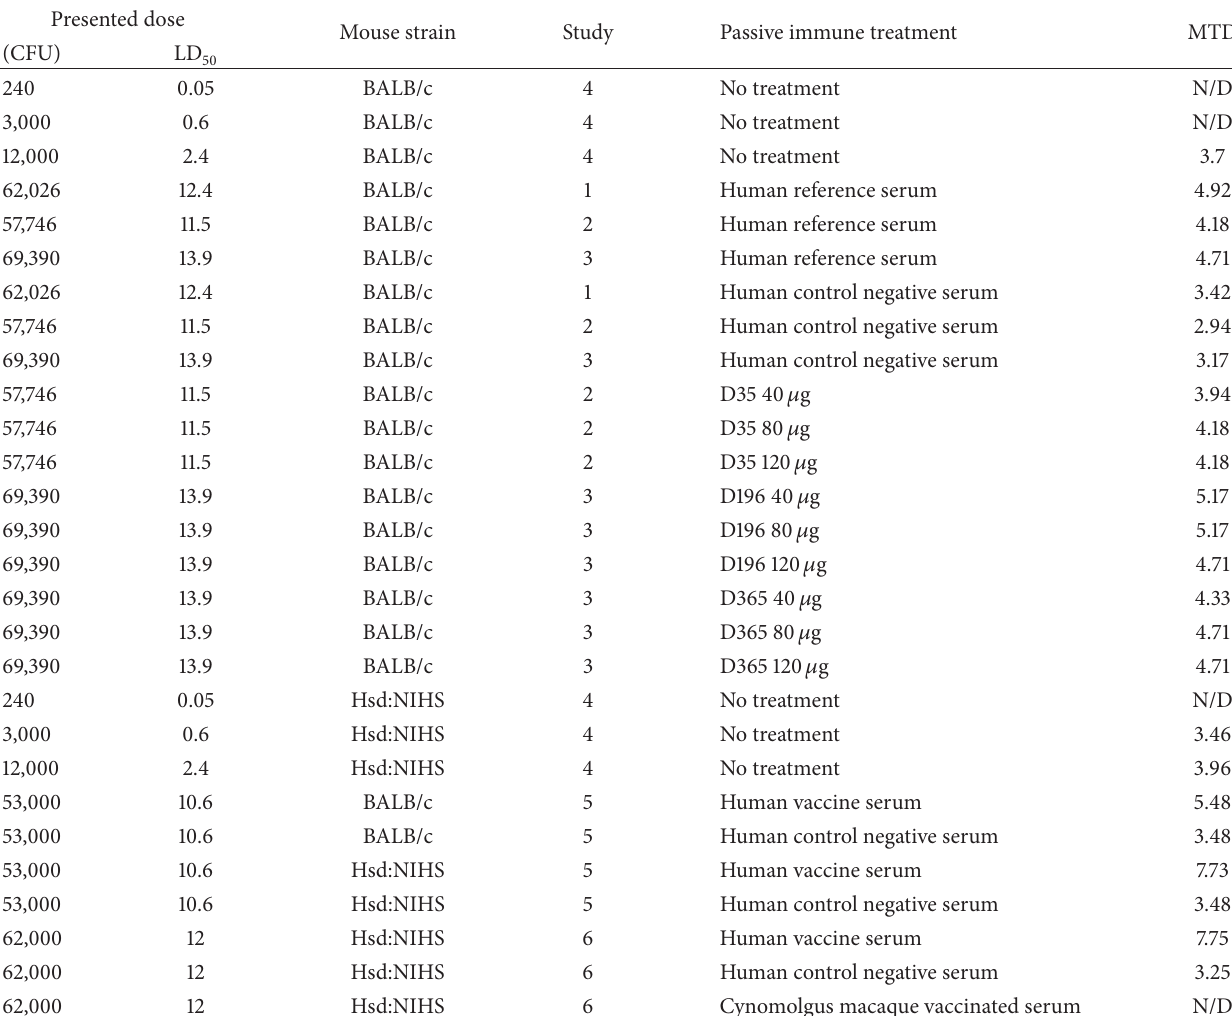
Table3:Atabularsummaryofpresenteddoseofaerosolised Y.pestis ,passiveimmunetherapytreatment,andMTDinBALB/candHsd:NIHS mice. The median time to death (MTD) was calculated using a Kaplan-Meier survival plot. N/D: not determined; over 50% of the